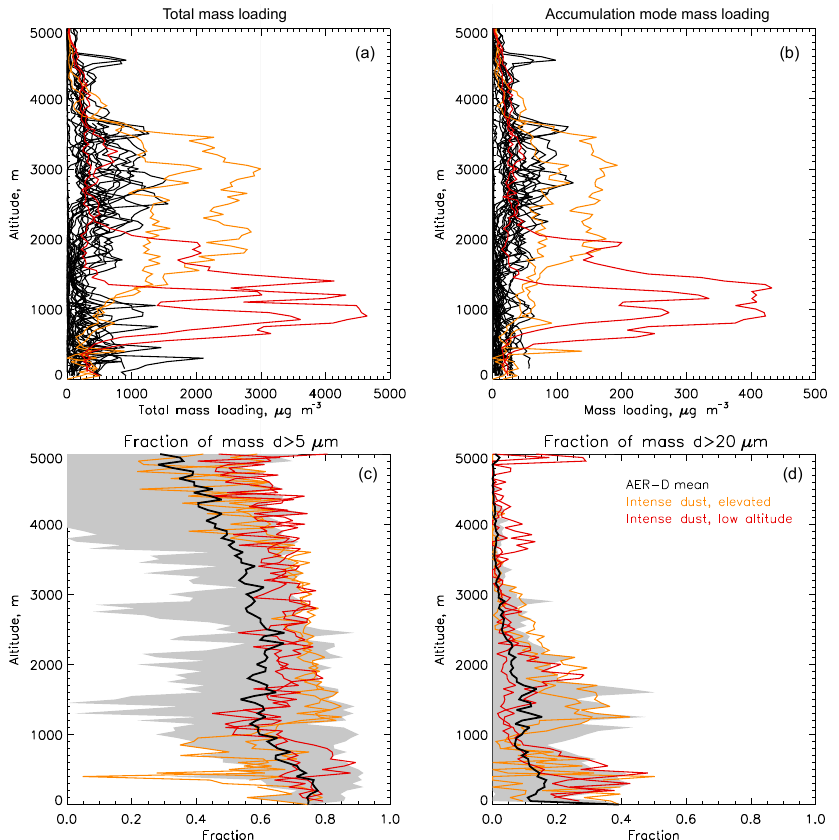
Figure 10. Profiles of aerosol mass loading calculated from in situ size distributions assuming a dust density of 2.65gcm − 3 . (a) Total mass loading for the full size distribution; (b) accumulation mode mass loading ( d <2.5µm); (c) fraction of mass at sizes greater than 5µm diameter; (d) fraction of mass at sizes greater than 20µm diameter. Black lines in (a) and (b) represent all AER-D profiles under low to medium AODs; red/orange represents the intense dust event with AODs ∼ 2 . 0 (b923/b924) separated by locations where the dust was elevated (orange) or at lower altitudes (red). In (c) and (d) grey shading represents AER-D 10th to 90th percentile range; the black line represents AER-D mean. Dust mass path values are given in the